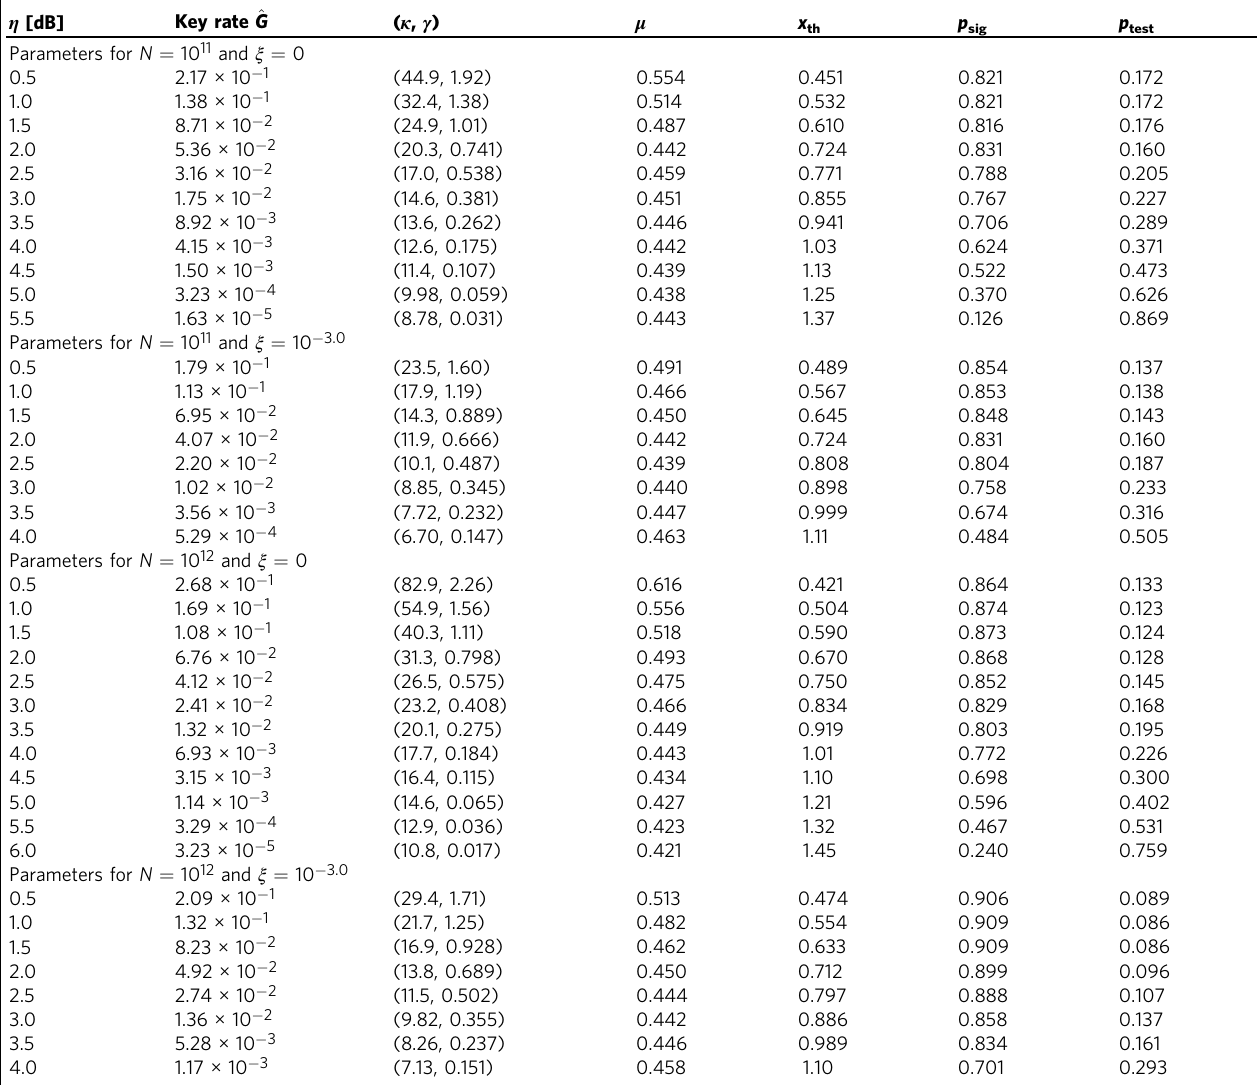
Table 1 Examples of optimized